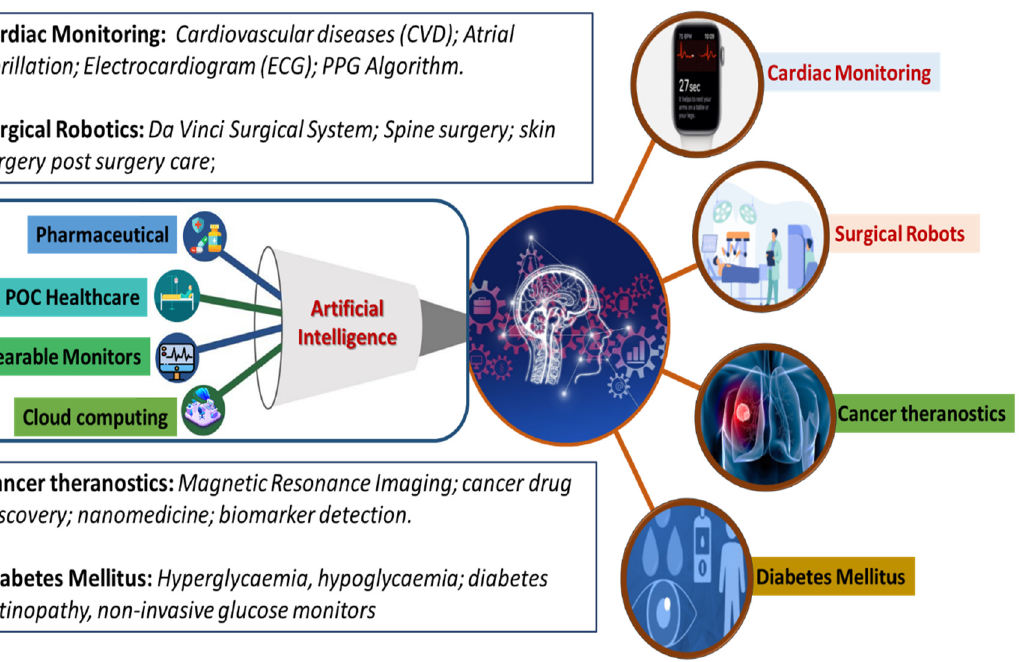
Figure 4. Schematic representation of the role of AI-based approaches in various themes of healthcare research, including cardiac monitoring, surgery, cancer theragnostic, and diabetes mellitus management.